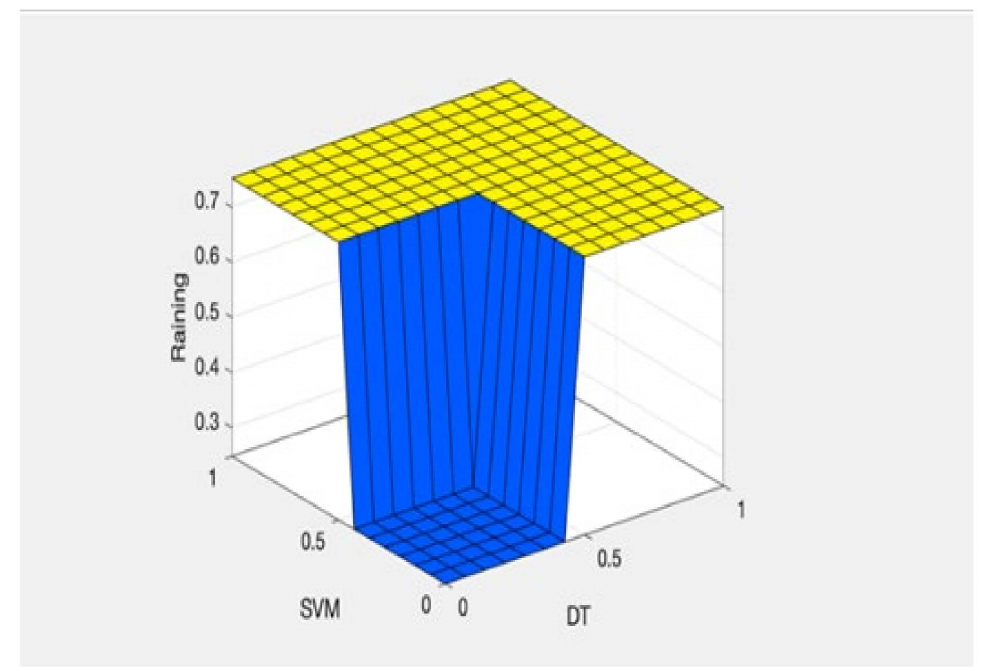
Figure 2. Rule surface of proposed fused technique for SVM and